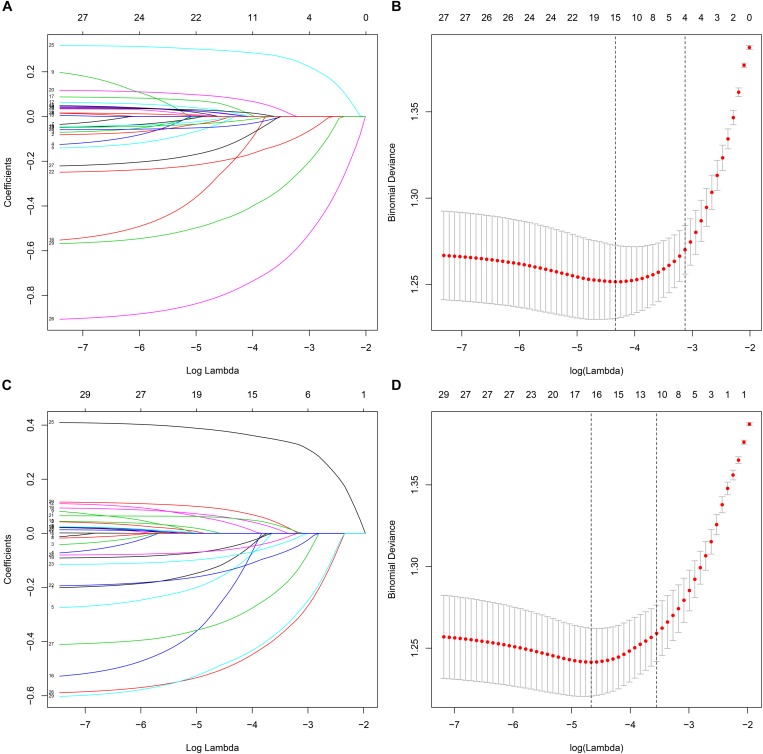
The variables filtering process of the Lasso regression. In order to avoid overfitting, the Lasso regression suggested including 4 and 11 variables when learning motivation level (A,B) and learning strategy level (C,D) was the endpoint, respectively. In the variable selection process, first of all, the univariate logistic regression and random forest were used to select potential SRL levels indicators. Then, based on these potential indicators, the initial multivariable logistic regression models were constructed. After that, we developed the reduced multivariable logistic regression models by screening the significant variables in the initial models. Additionally, the Lasso regression was performed based on these potential SRL levels indicators found by the univariate logistic regression and random forest. Therefore, in this study, the Lasso regression was only used to ensure that the reduced multivariable logistic regression models were not overfitting rather than for variable selection and modeling.